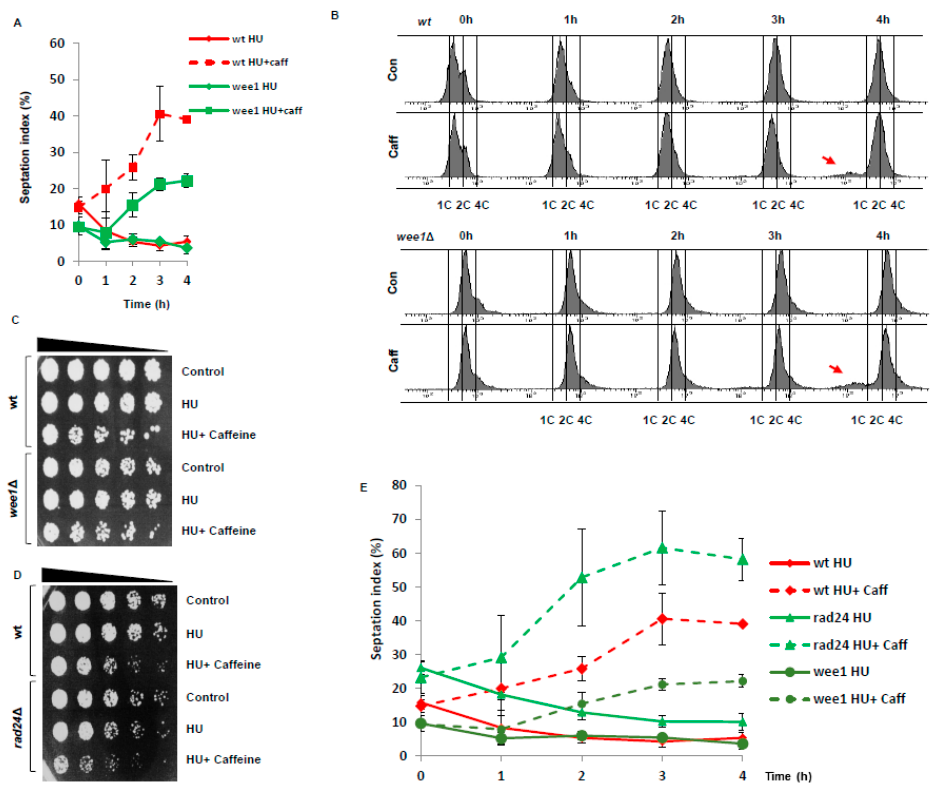
Figure 4. Differential effects of caffeine on cell cycle progression in S. pombe wee1 Δ and rad24 Δ mutants. ( A ). Cultures of wt and wee1 Δ cells were incubated with 10 µg/mL phleomycin for 2 h. The cultures were then incubated for a further 4 h with or without 10 mM caffeine and samples harvested at the indicated time points. Cells were fixed in 70% ethanol, stained with aniline blue and the septation index determined by fluorescent microscopy. Error bars represent the S.E. of 3 experiments. ( B ). Samples from A were stained with propidium iodide and analysed by FACS. Arrows indicate cell with mis-segregated chromosomes. ( C ). Wt and wee1 Δ cells were incubated with 20 mM HU for 2 h. The cultures were then incubated for a further 2 h in the presence of 10 mM caffeine as indicated. Cultures were adjusted for relative cell numbers, serially diluted and plated unto YES agar plates. Plates were incubated